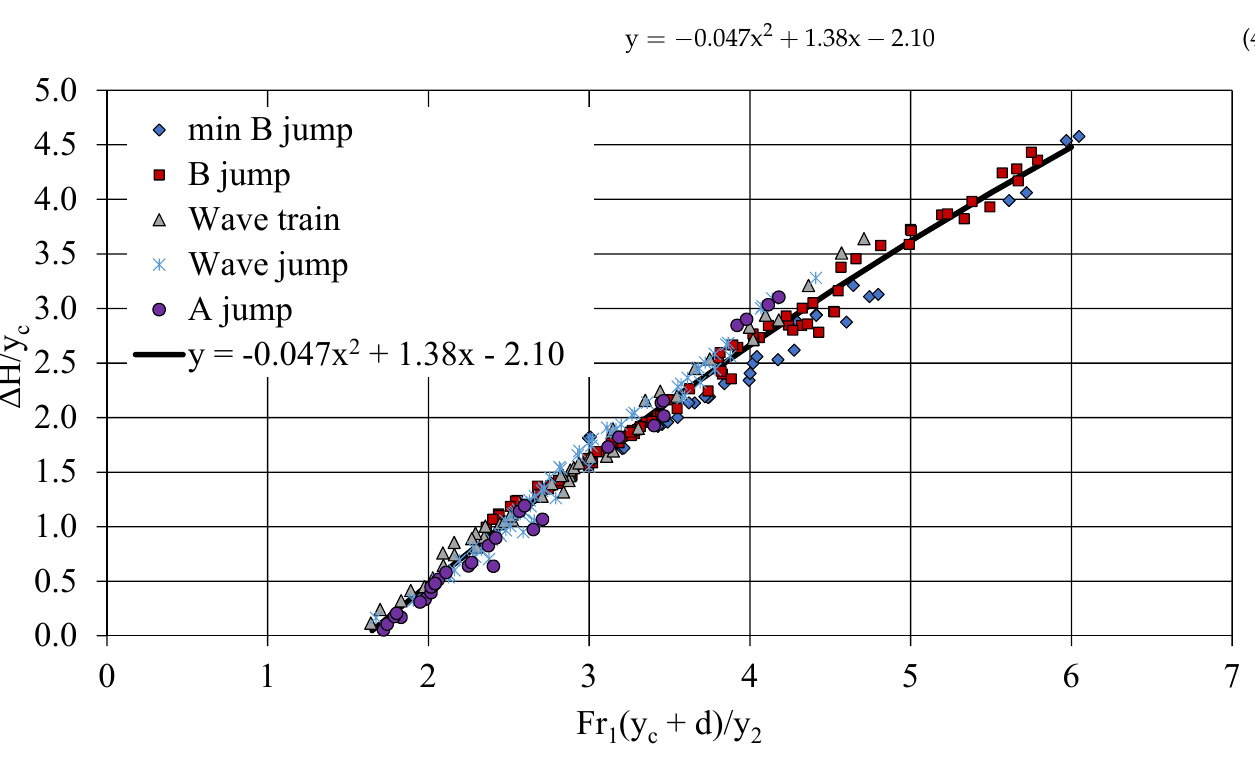
Figure 6. Normalized energy loss at the step ∆ H/y c versus Fr 1 (y c + d)/y 2